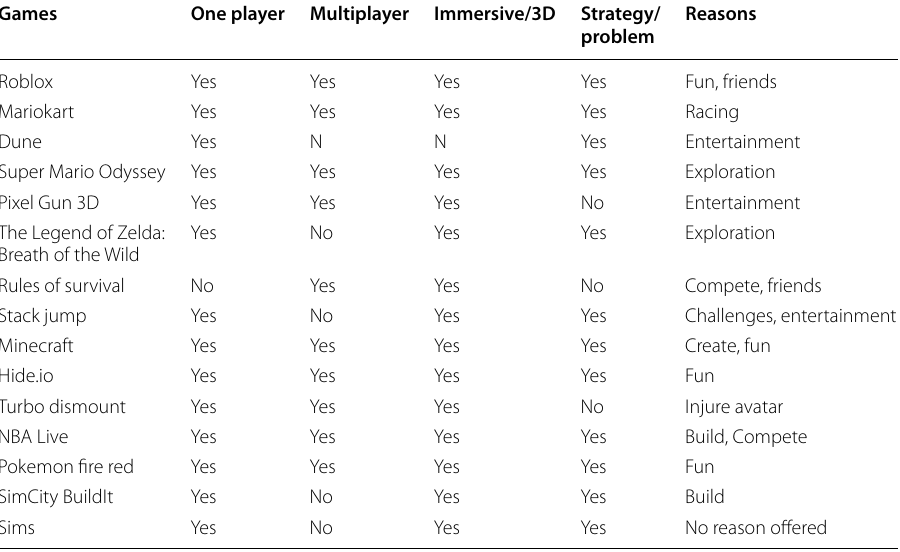
Table 3 An overview of the games the students play and the reasons Games One player Multiplayer Immersive/3D Strategy/ Reasons problem Roblox Yes Yes Yes Yes Fun, friends Mariokart Yes Yes Yes Yes Racing Dune Yes N N Yes Entertainment Super Mario Odyssey Yes Yes Yes Yes Exploration Pixel Gun 3D Yes Yes Yes No Entertainment The Legend of Zelda: Yes No Yes Yes Exploration Breath of the Wild Rules of survival No Yes Yes No Compete, friends Stack jump Yes No Yes Yes Challenges, entertainment Minecraft Yes Yes Yes Yes Create, fun Hide.io Yes Yes Yes Yes Fun Turbo dismount Yes Yes Yes No Injure avatar NBA Live Yes Yes Yes Yes Build, Compete Pokemon fire red Yes Yes Yes Yes Fun SimCity BuildIt Yes No Yes Yes Build Sims Yes No Yes Yes No reason